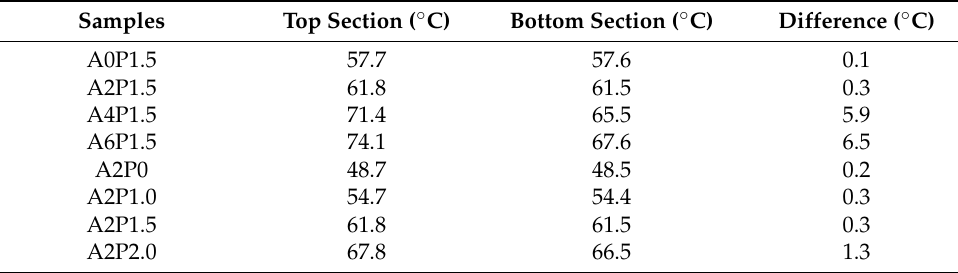
Table 9. Softening point differences of composite modified